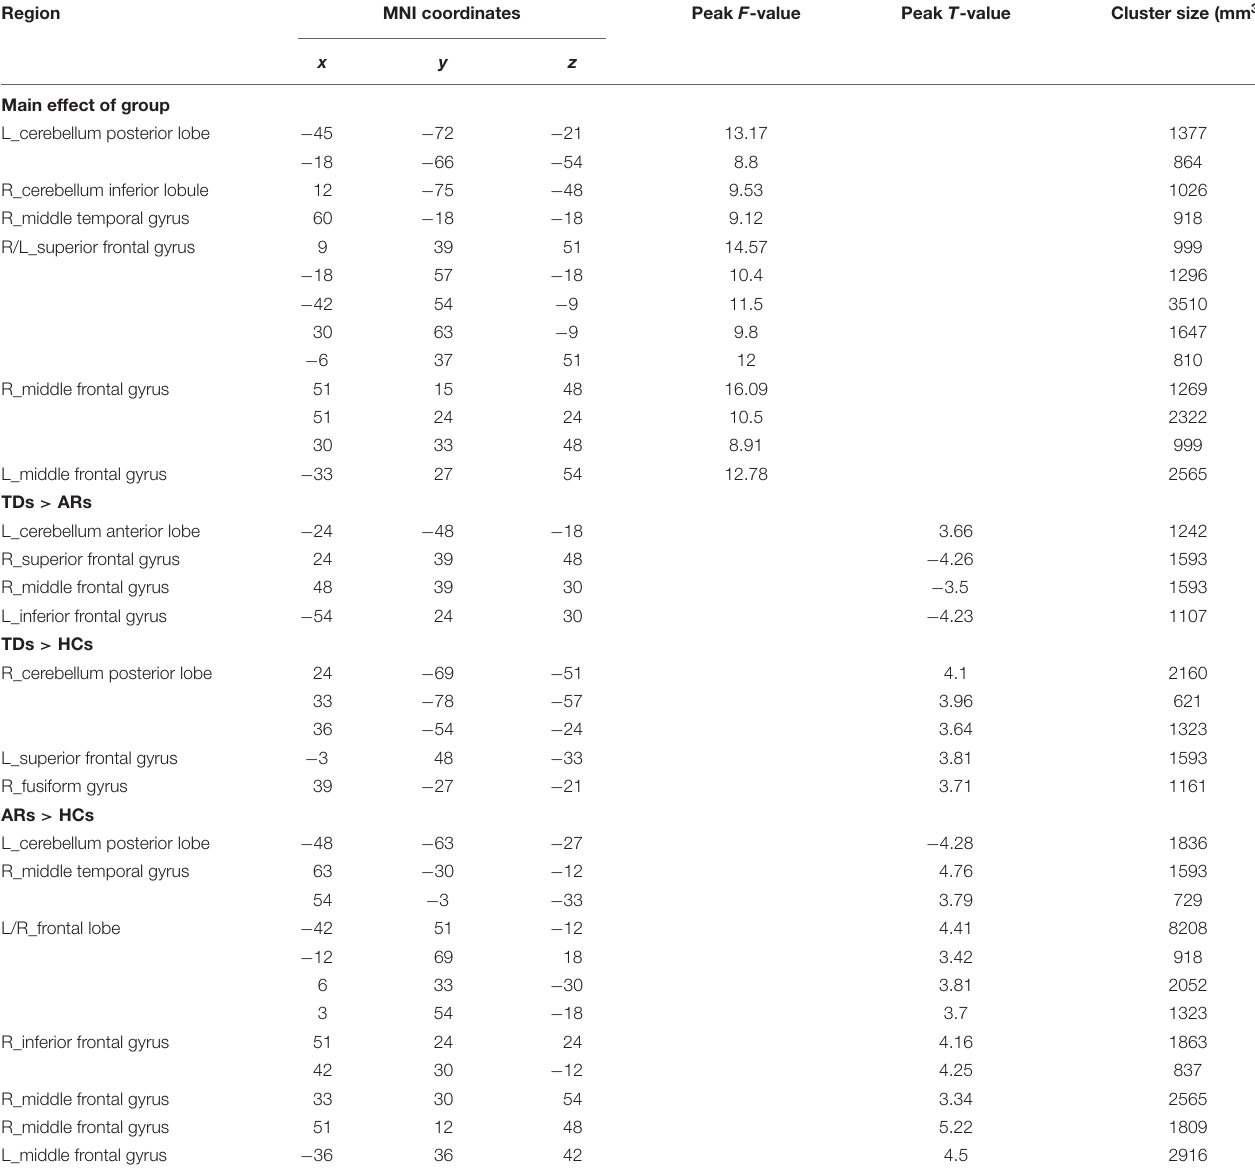
TABLE 2 | The difference of global FCD among TDs, ARs, and HCs.